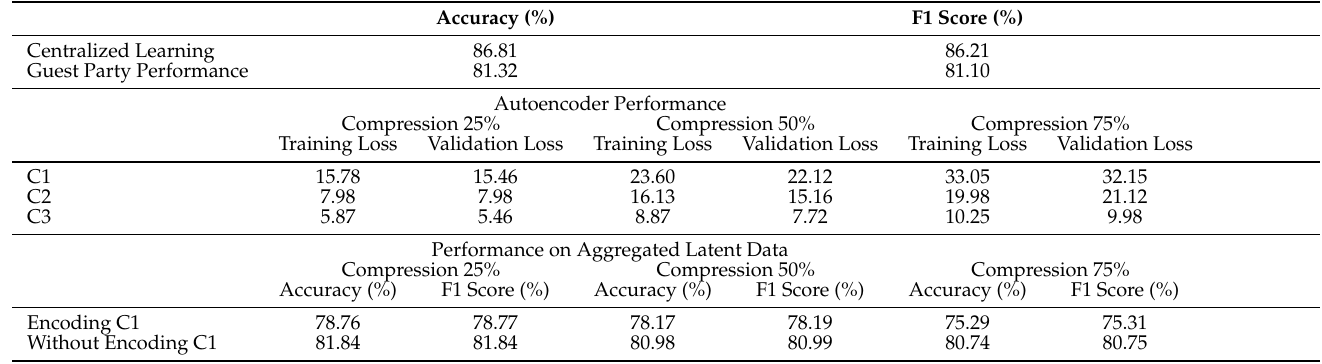
Table 7. Experimental Results on Heart Disease Prediction Dataset.